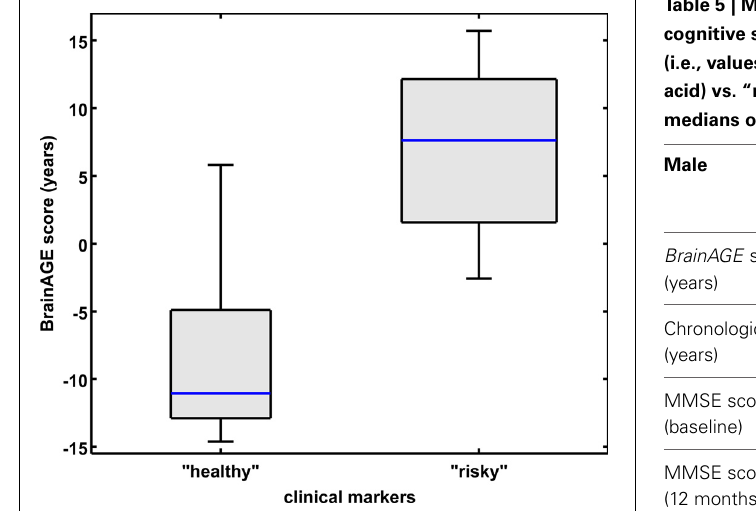
FIGURE 4 | Combined analysis of physiological and serum data parameters in the male sample. BrainAGE score distributions of male subjects with “healthy” markers (i.e., values equal to or below the medians of BMI, DBP, GGT, and uric acid; n = 9) vs. “risky” markers (i.e., values equal to or above the medians of BMI, DBP, GGT, and uric acid; n = 14; p < 0 . 05). Gray boxes contain values between the 25th and 75th percentiles of the groups, including the median. Error bars indicate data within 1.5 times the interquartile range. The width of the boxes is proportional to group size.